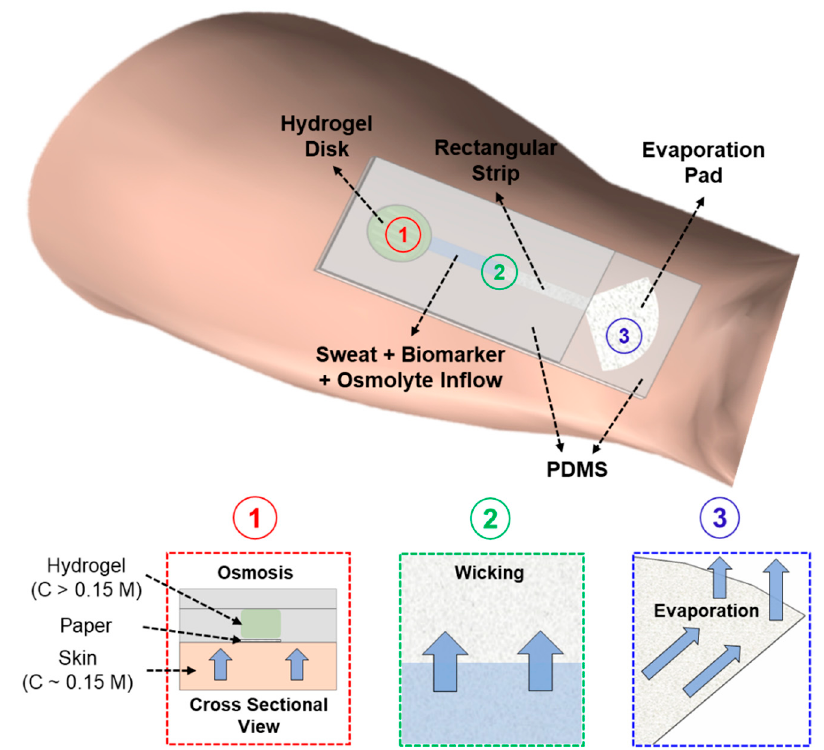
Figure 1. Schematic of the wearable, zero-powered, and non-invasive sweat sensing platform on skin. The platform comprises of a hydrogel pad and a paper microfluidic channel. Simultaneous action of osmosis, capillary wicking, and evaporation leads to long-term sweat withdrawal from skin even at resting perspiration rates.